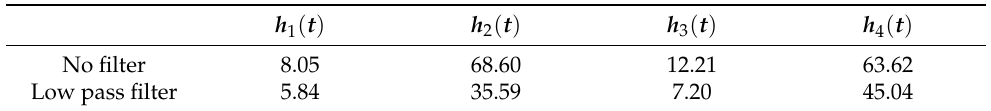
Table 5. Noise variance estimates on the h k ( t ) in the absence and presence of low-pass filtering in the case of the higher SNR value (31 [dB]).